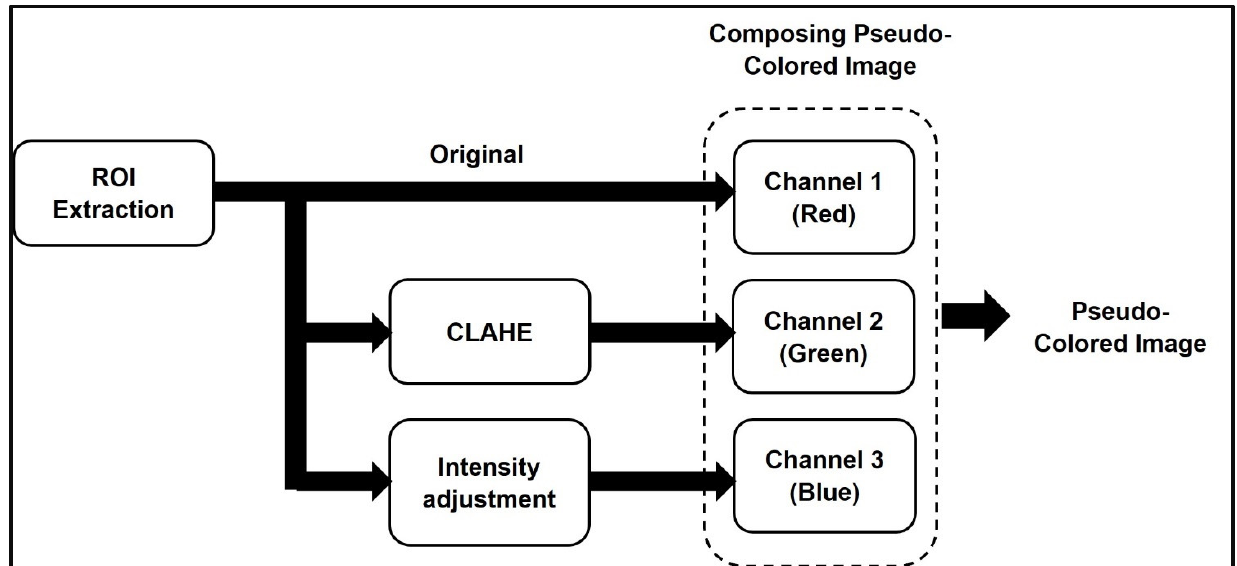
Figure 2. The concept of generating three-channel pseudo-color mapping image.